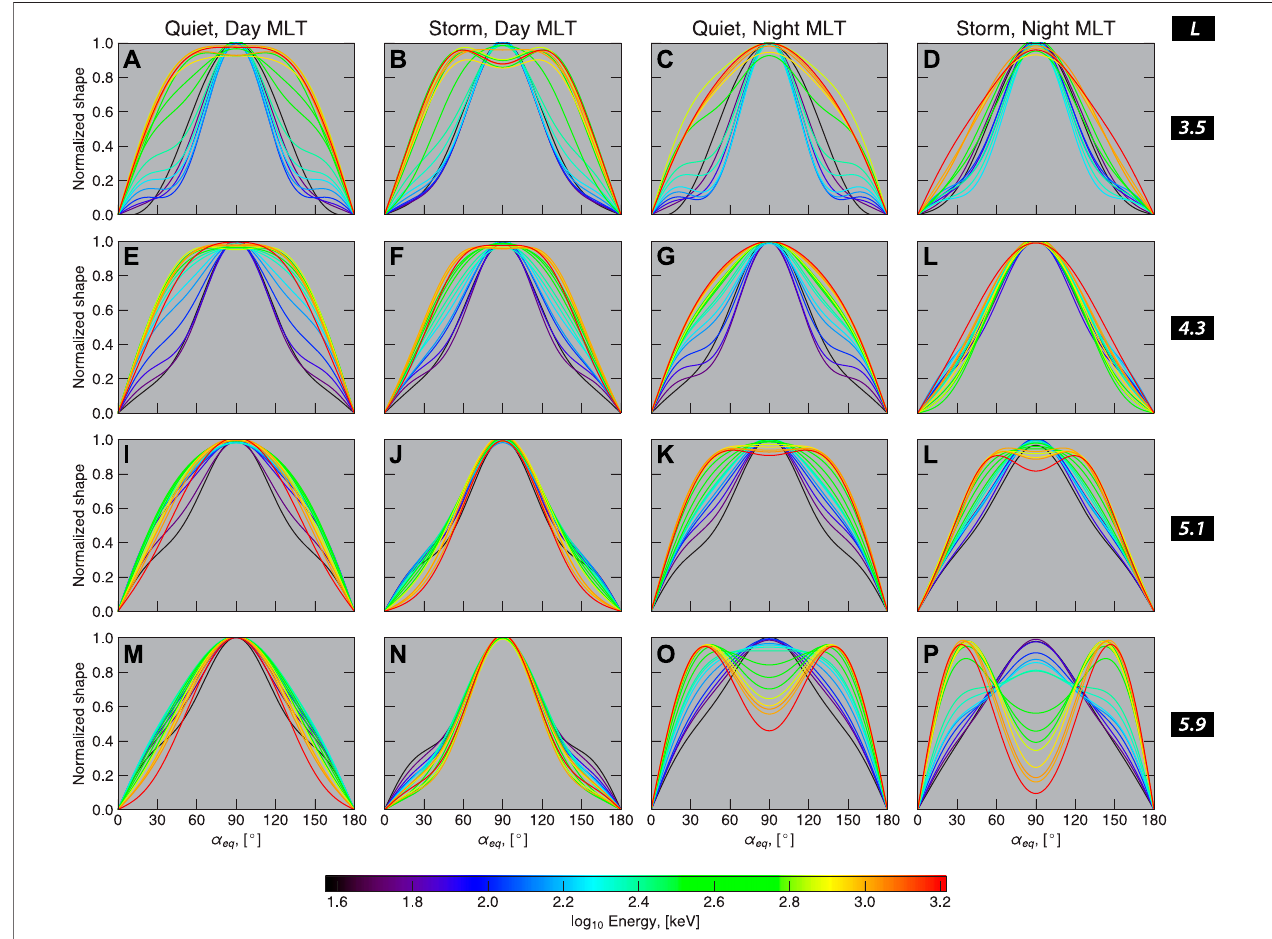
FIGURE 6 | Energy dependence of pitch angle shapes at different L-values for quiet and storm conditions on the day and nightside MLT.